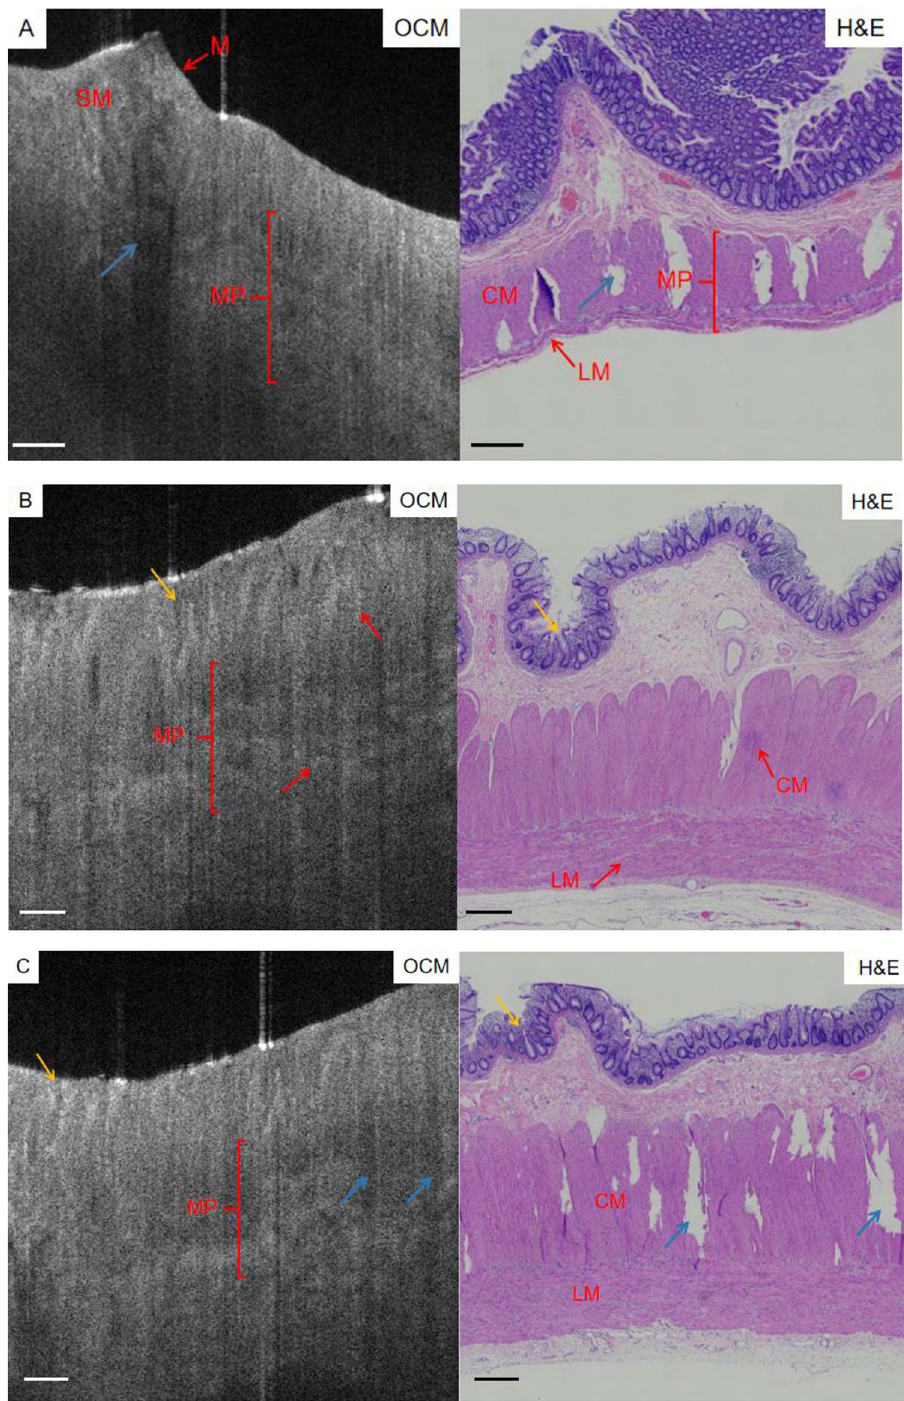
Figure 3. OCM images of HSCR dilated segments with H&E stained images. Scale bars 500